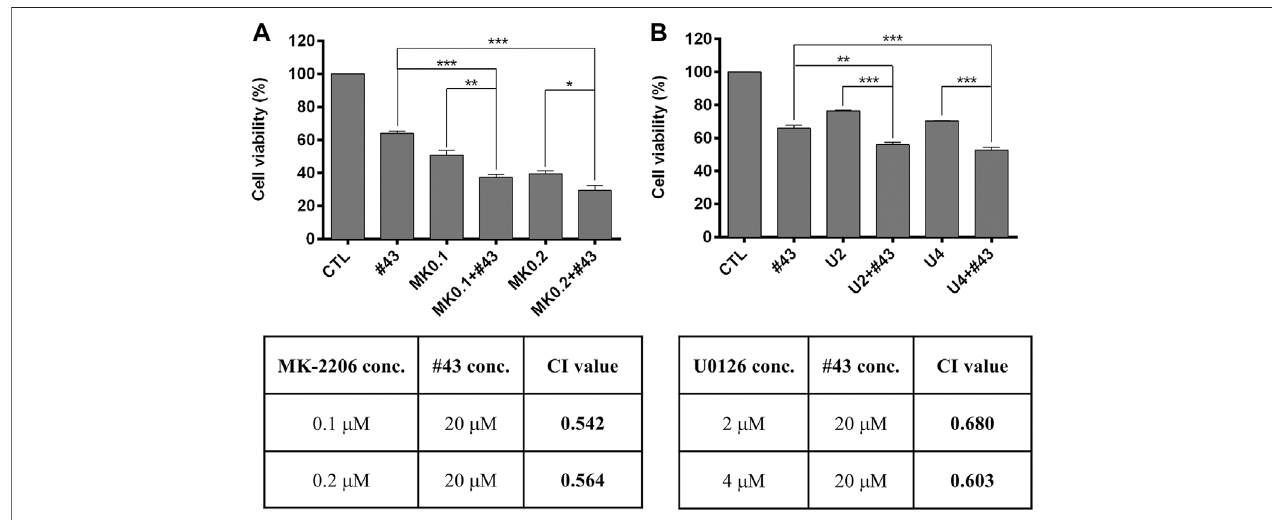
FIGURE 7 | MK-2206 and U0126 potentiate the growth inhibitory effect of #43 in MCF-7 cells. (A) Viability of cells treated with 20 μ M #43 either alone or in combination with 0.1 and 0.2 μ M MK-2206 (MK0.1, MK0.2) for 72 h, followed by MTT assay. (B) Viability of cells treated with 20 μ M #43 either alone or in combination with2and4 μ MU0126(U2,U4)for72 h,followedbyMTTassay.Thecombinationindex(CI)wascalculatedbyCompusynsoftware.Dataarepresentedasmean±SEM of at least three independent experiments. *, p < 0.05; ** p < 0.01; ***, p < 0.001 by one-way ANOVA followed by Bonferroni t